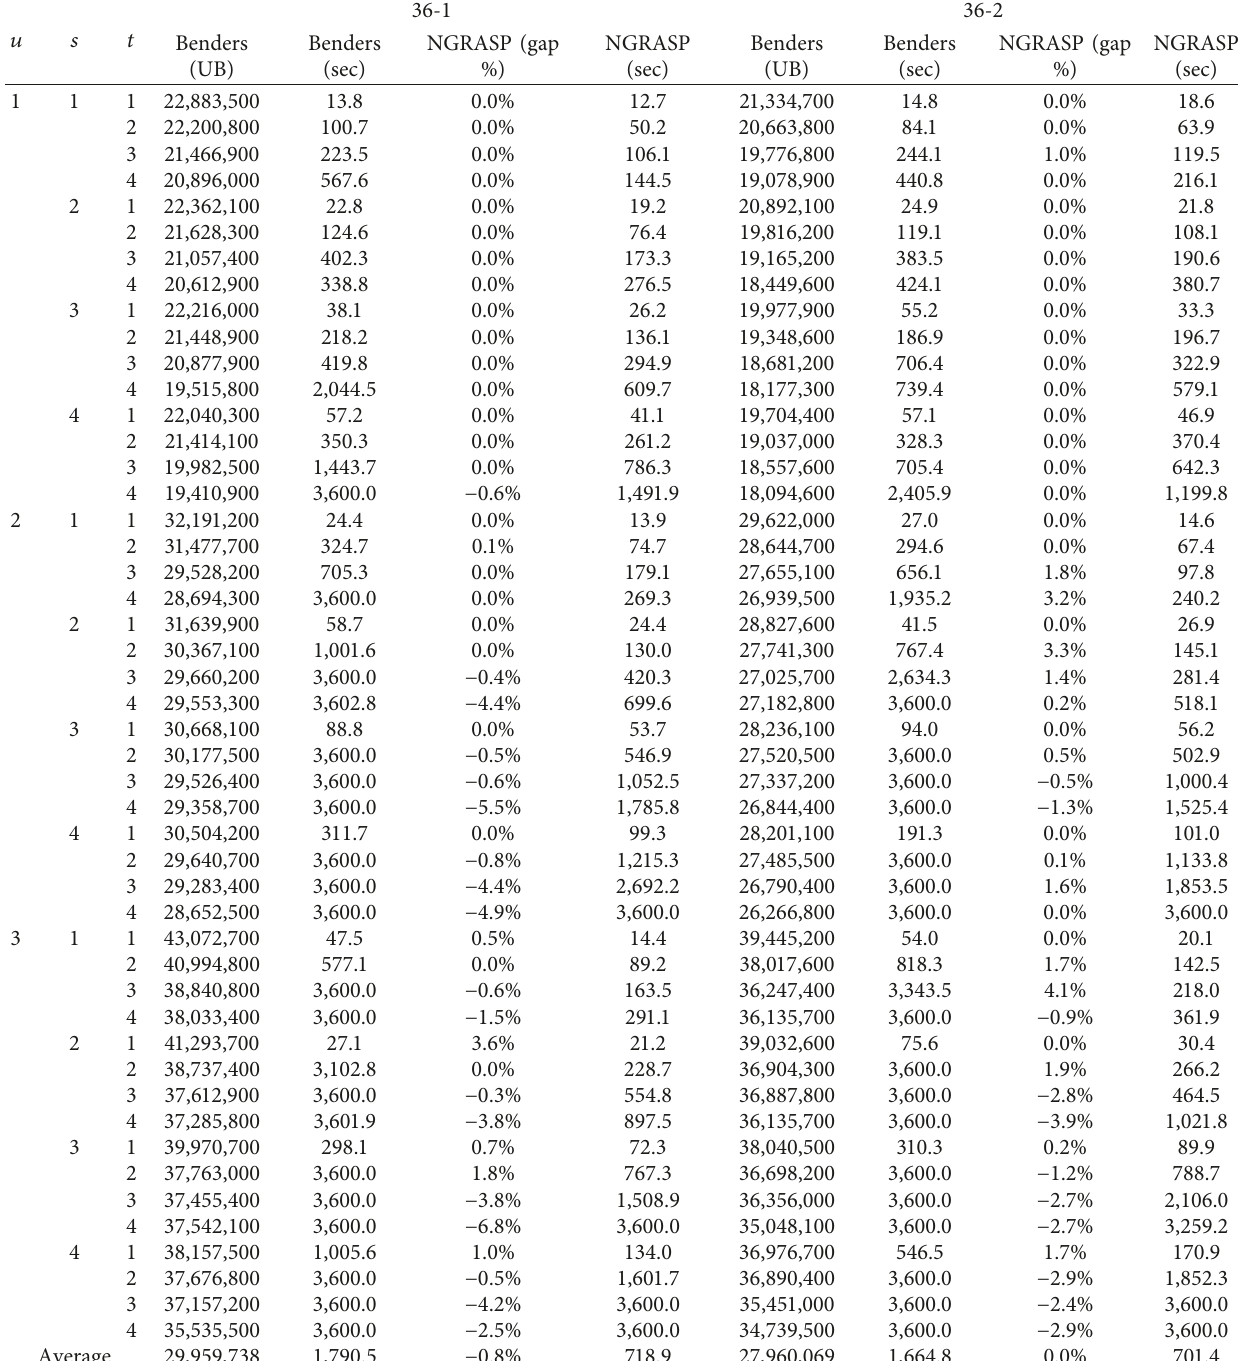
Table 8: Computational results on 36-node